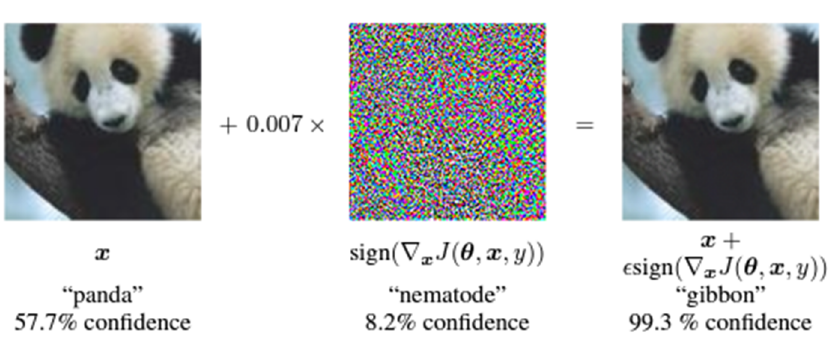
Figure 3. An illustration of applying FGSM on GoogLeNet. Adapted with permission from [2], arXiv, 2013.